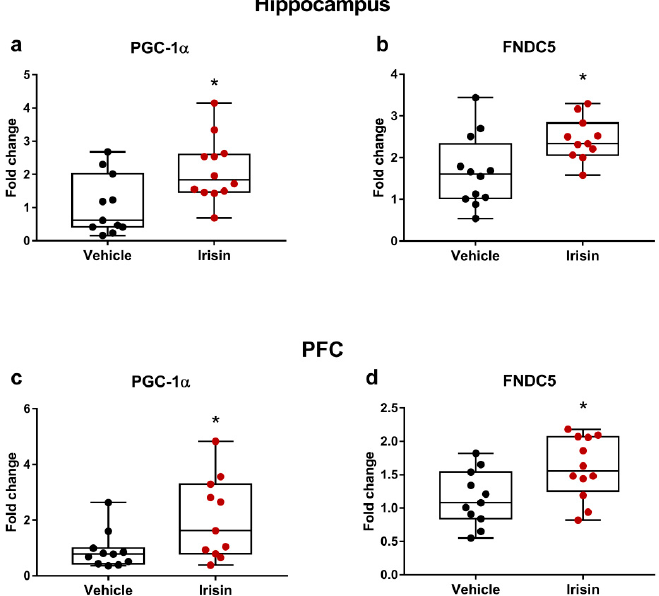
Figure 6. Effect of short-term systemic administration of irisin on FNDC5/irisin system in the hippocampus and the PFC. Gene expression of Pgc-1 α ( a , c ) and FNDC5 ( b , d ) was assessed by qRT-PCR. Shapiro–Wilk test was followed by Student’s t test for all data except for Pgc-1 α in the PFC. Data are presented as box-and-whisker with median and interquartile ranges, from max to min, with all data points shown. * p < 0.05.